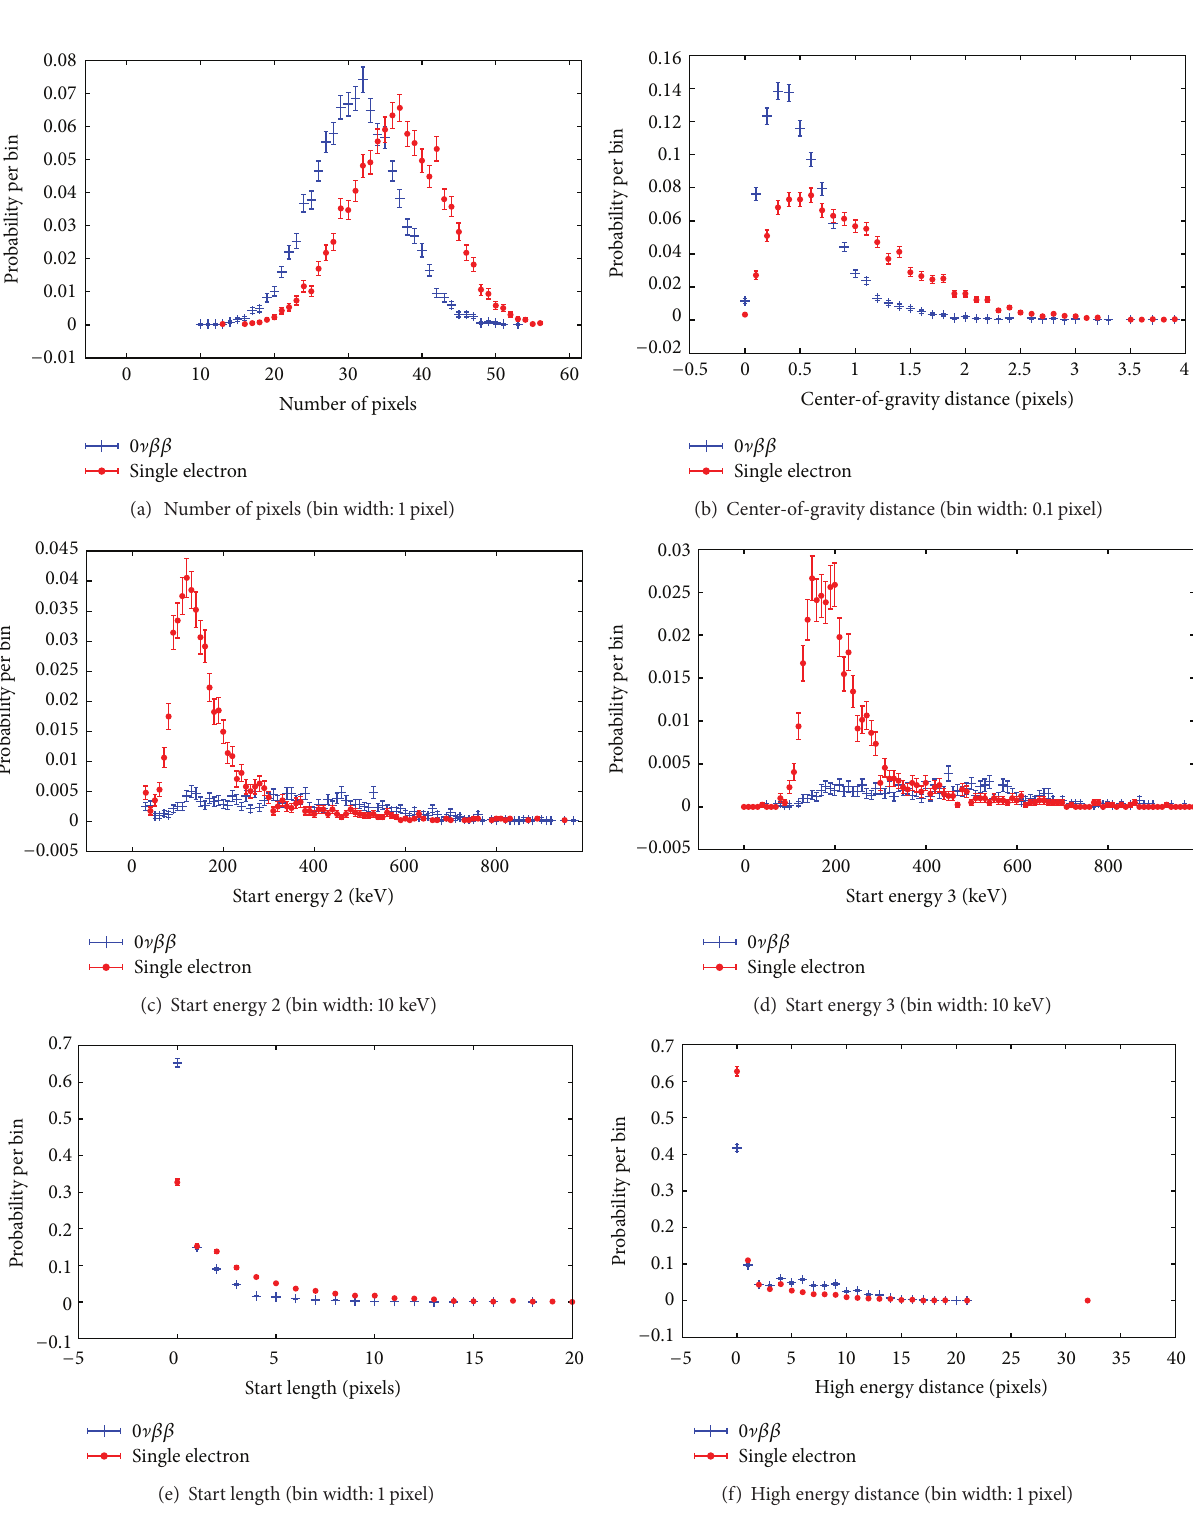
Figure12:Probabilitiesperbinfortheoccurrenceoffeaturevaluesinaneventfor 0 ] 𝛽𝛽 -decaysandforsingleelectronswithenergydeposition around 𝐸 𝑄 for a 3 mm thick CdTe sensor with 110 𝜇 m pixel pitch. The bin width is given in the caption of each